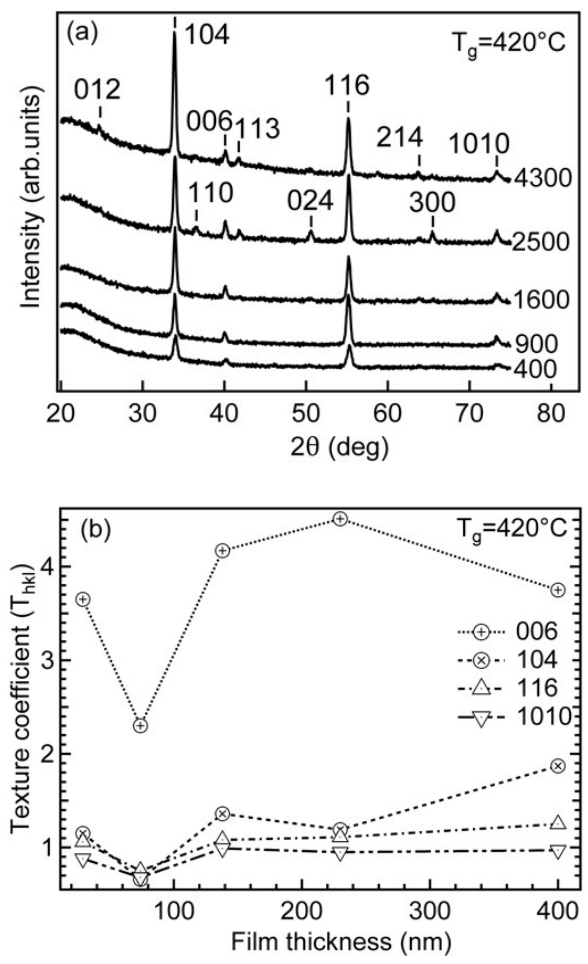
Figure 2. Diffraction patterns of chromia thin films with different cycle counts ( a ) and ( b ) variation of texture coefficient T hkl for the dominating reflections (104), (006), (116) and (1010) as a function of the film thickness ( b ) deposited at 420 °C.